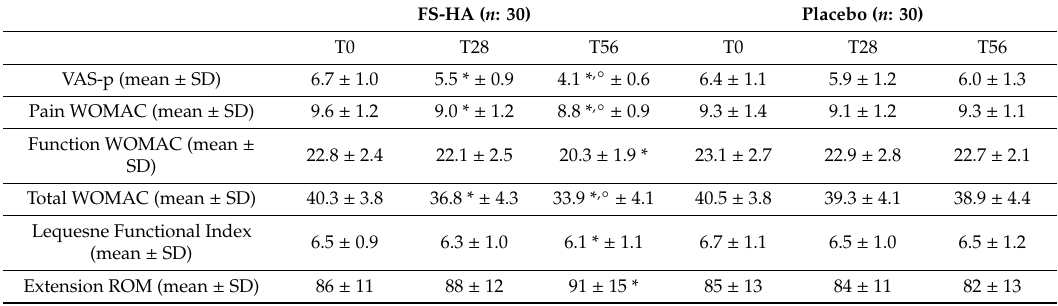
Table 1. Changes in VAS-p, WOMAC (and related subscales) indexes, Lequesne functional index (LFI) and knee extension ROM in the enrolled subjects during the